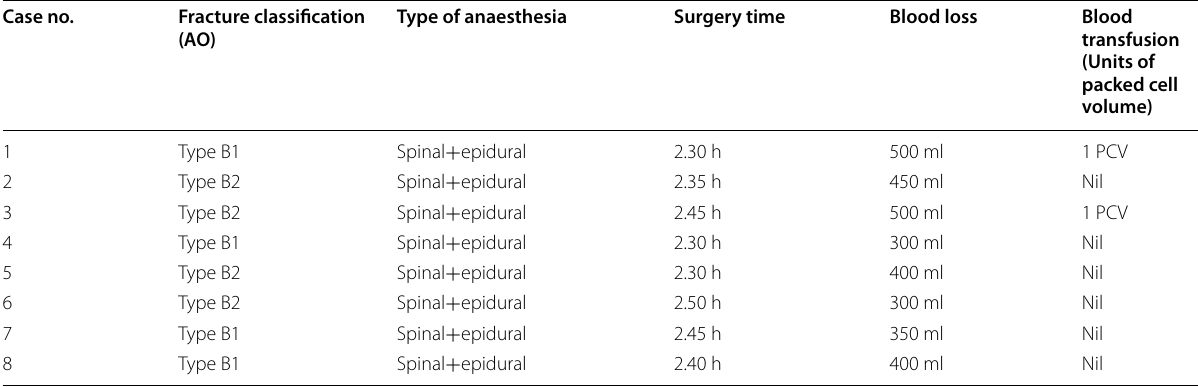
Table 2 Patient data of our series Case